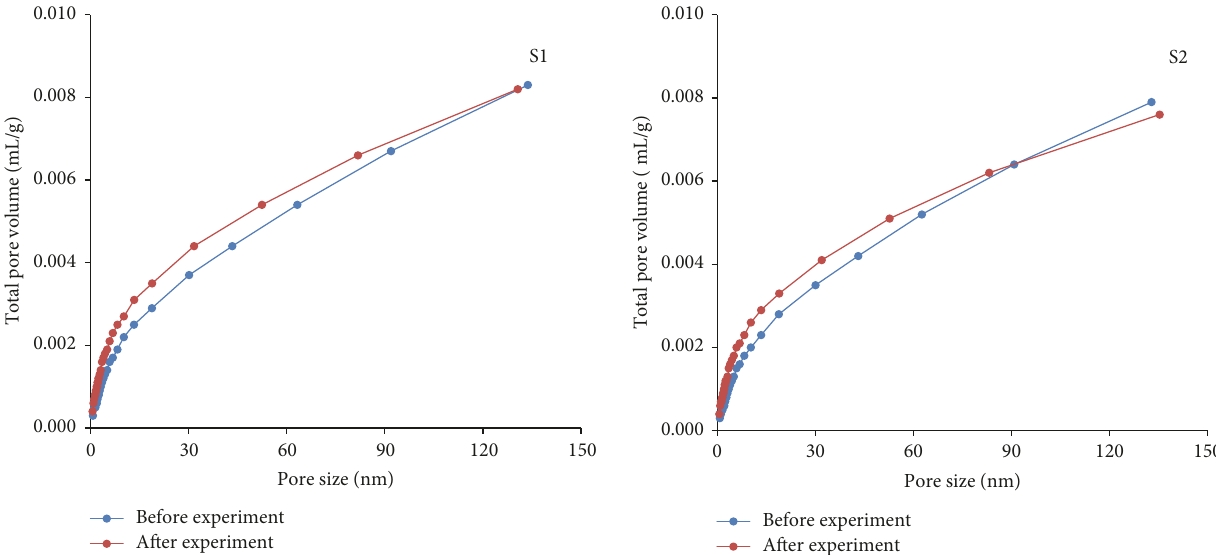
Figure 14: Cumulative pore volumes before and after the